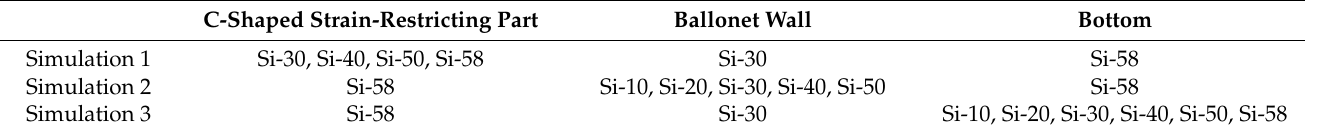
Figure 3. Definition of the bending angle of the actuator. Table 2. Material properties for 3 different simulation